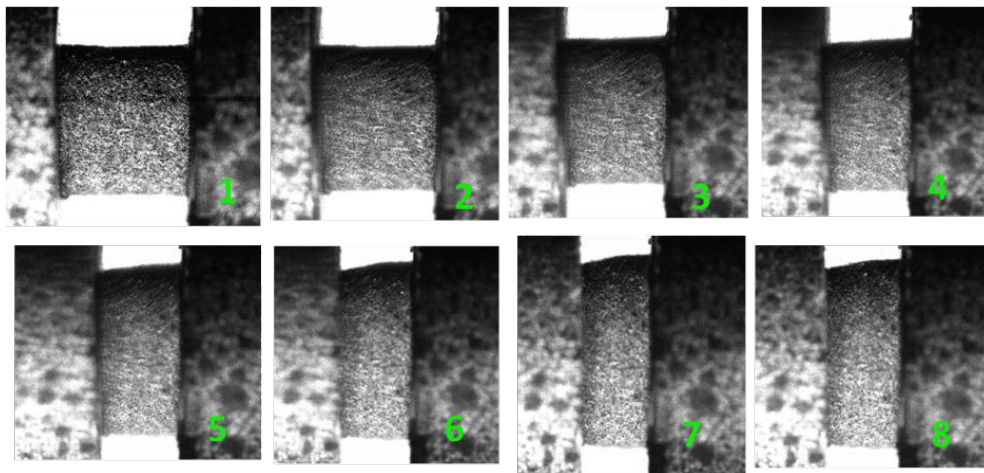
Figure 5. Deformation processes of H-80W recorded by a high-speed digital camera under a strain rate of 2460 s −1 . The green numbers in the images correspond to the numbers marked in Figure 4.